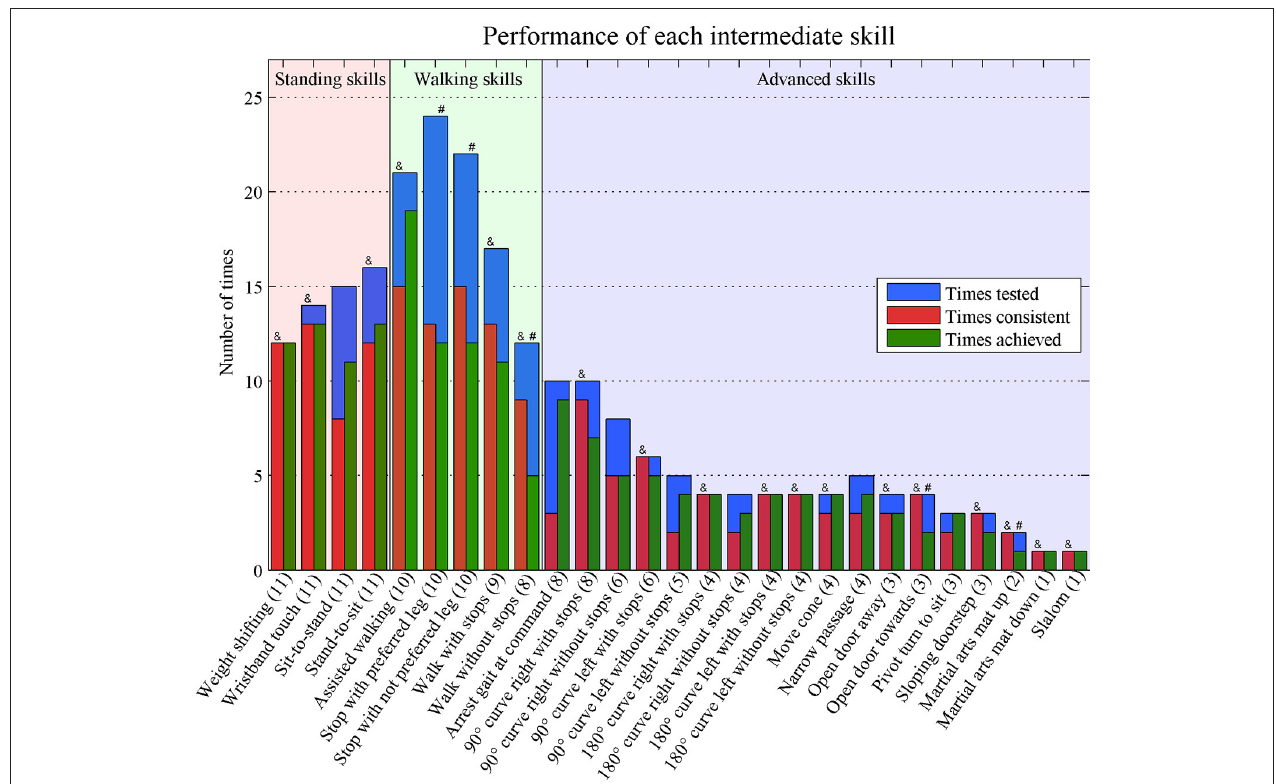
FIGURE 3 | Times performed consistent and achieved of each separate intermediate skill. Numbers in brackets represent the number of tested participants. Consistent = performed the same in the first two attempts (successful-successful or failure-failure). Achieved = at least two out of three successful attempts & = > 70% performed consistent # = achieved in ∼ 50% of the